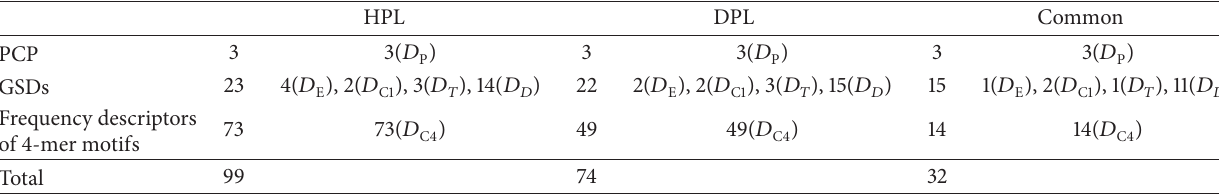
Table 8: Distribution of the extracted